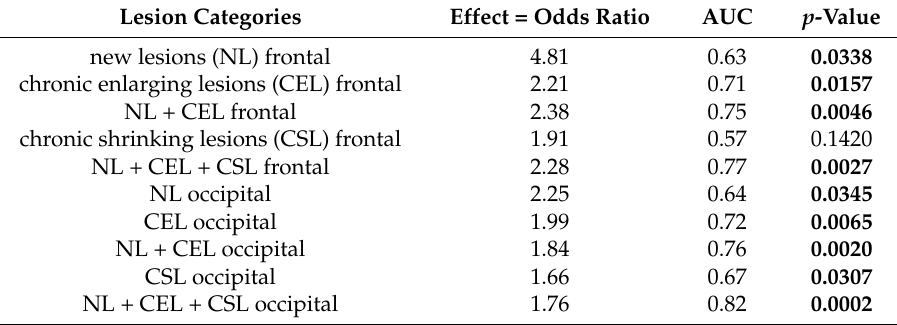
Table 1. Logistic regressions of lateral geniculate nucleus (LGN) volume reduction and ipsilateral lesion count along the optic radiation. These calculations were carried out separately for the frontal and the occipital half of the corpus callosum. Effect = Euler’s number to the power of the coefficient of the independent variable. AUC = Area under the Receiver Operating Characteristic (ROC) curve. p -value = p -value calculated with the Wald test. All values rounded to two decimal places, if needed ( p -values to four decimal places). All p -values below 0.05 are accentuated in bold print. Results were not corrected for multiple comparisons.